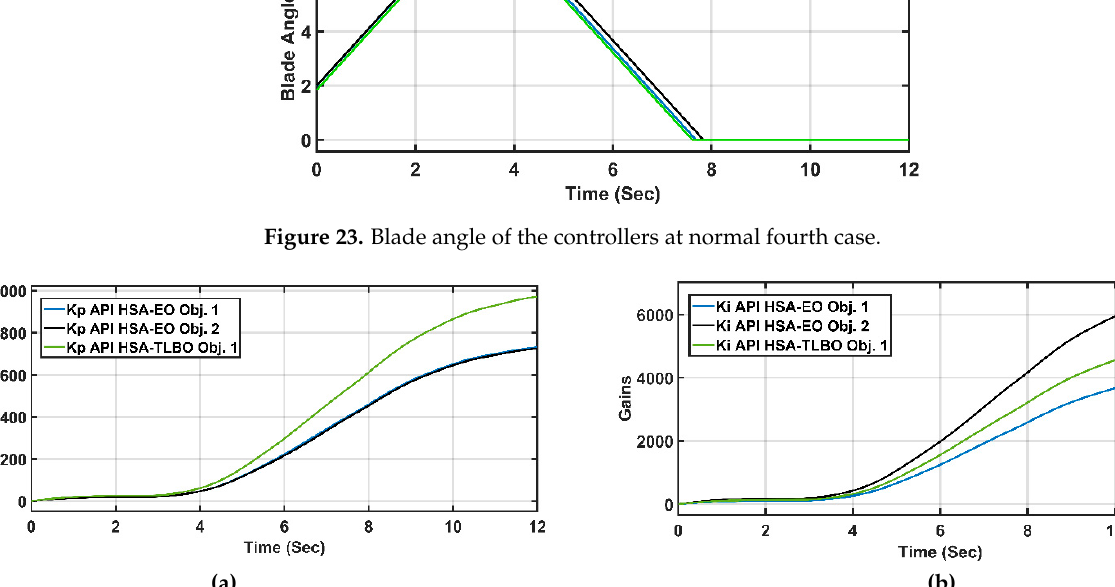
Table 8. Numerical comparison between the controllers at normal fourth case.